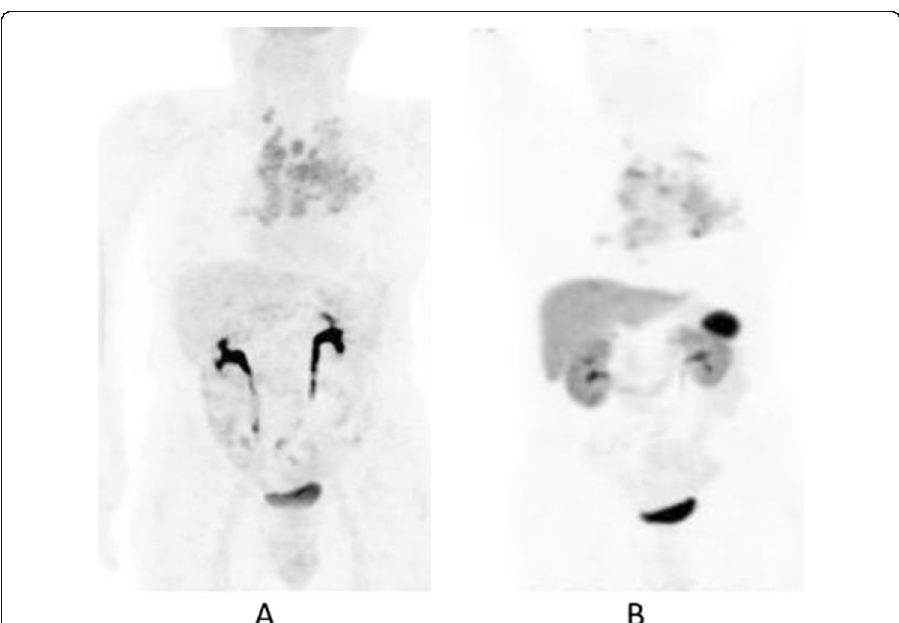
Fig. 60 68 Ga-DOTA peptide, suspected NET of the pancreas, false positive (inflammation), compared with FDG. Clinical history : 65 y.o. man with suspected NET of the pancreas. PET/CT findings : FDG: there is no significant uptake in the pancreas. Intense symmetric uptake in mediastinal lymph nodes ( a MIP). 68 Ga- DOTANOC: there is increased symmetrical uptake in mediastinal lymph nodes but no significant uptake in